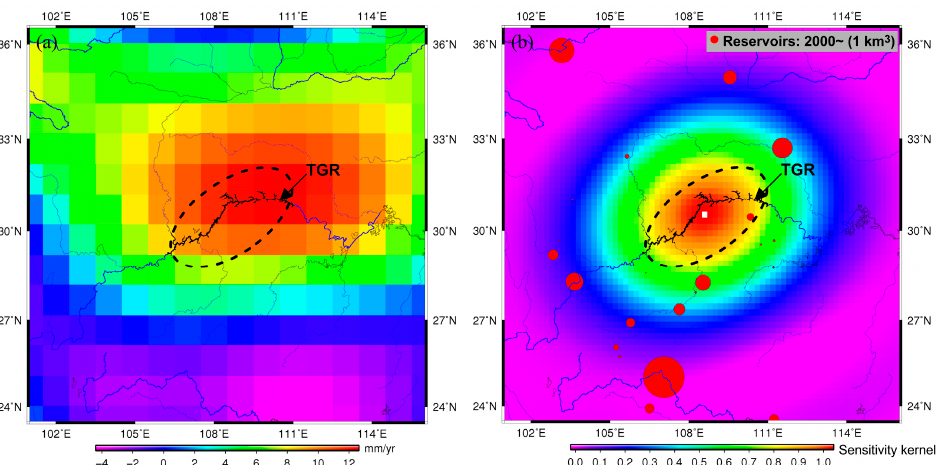
Figure 5. ( a ) Trends in TWS changes in the TGR and surrounding areas derived from the Center for Space Research (CSR) GRACE product (RL05) after Gaussian filtering (350 km) from 2003–2012 in mm/yr. ( b ) GRACE averaging kernels used to estimate the TGR mass variability. Red circles show 13 large reservoirs surrounding TGR since 2000; their sizes represent different reservoir capacities.